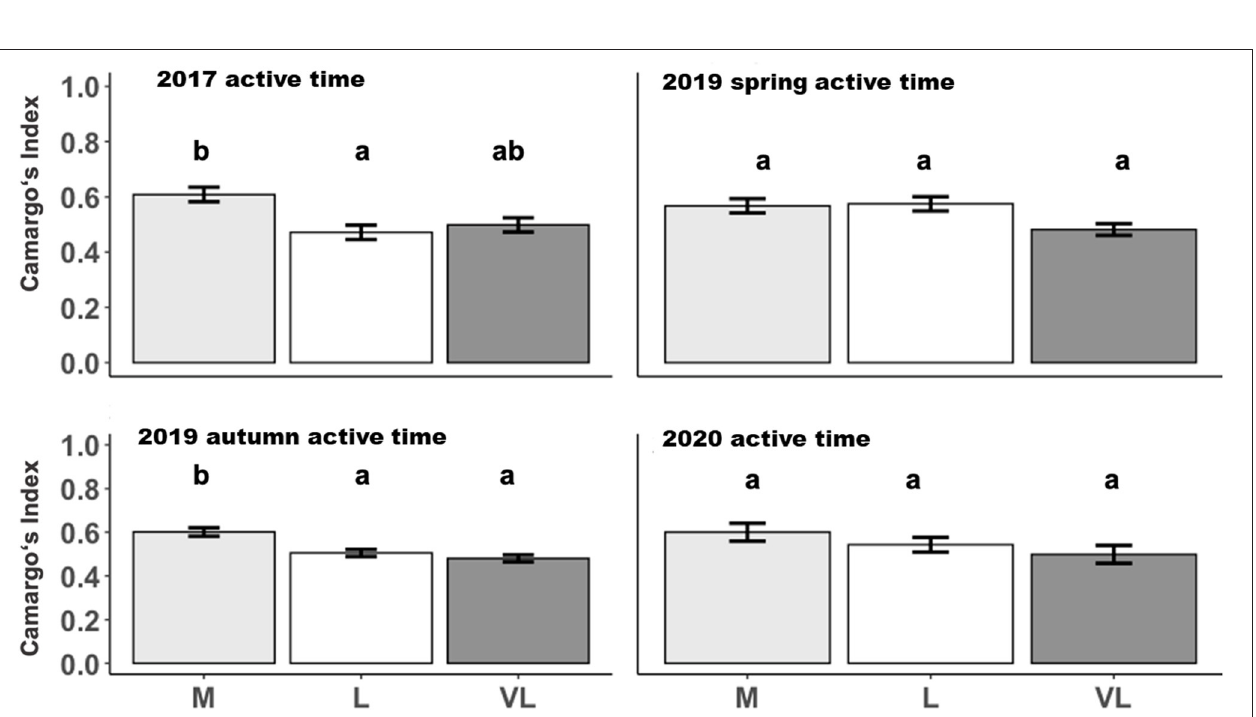
FIGURE 3 | Estimated means ( ± SE) of the Camargo Index during active time as influenced by the grazing period and grazing intensity. M, moderate; L, lenient; VL, very lenient stocking rate. Identical lowercase letters indicate that means are not different at p < 0.05.